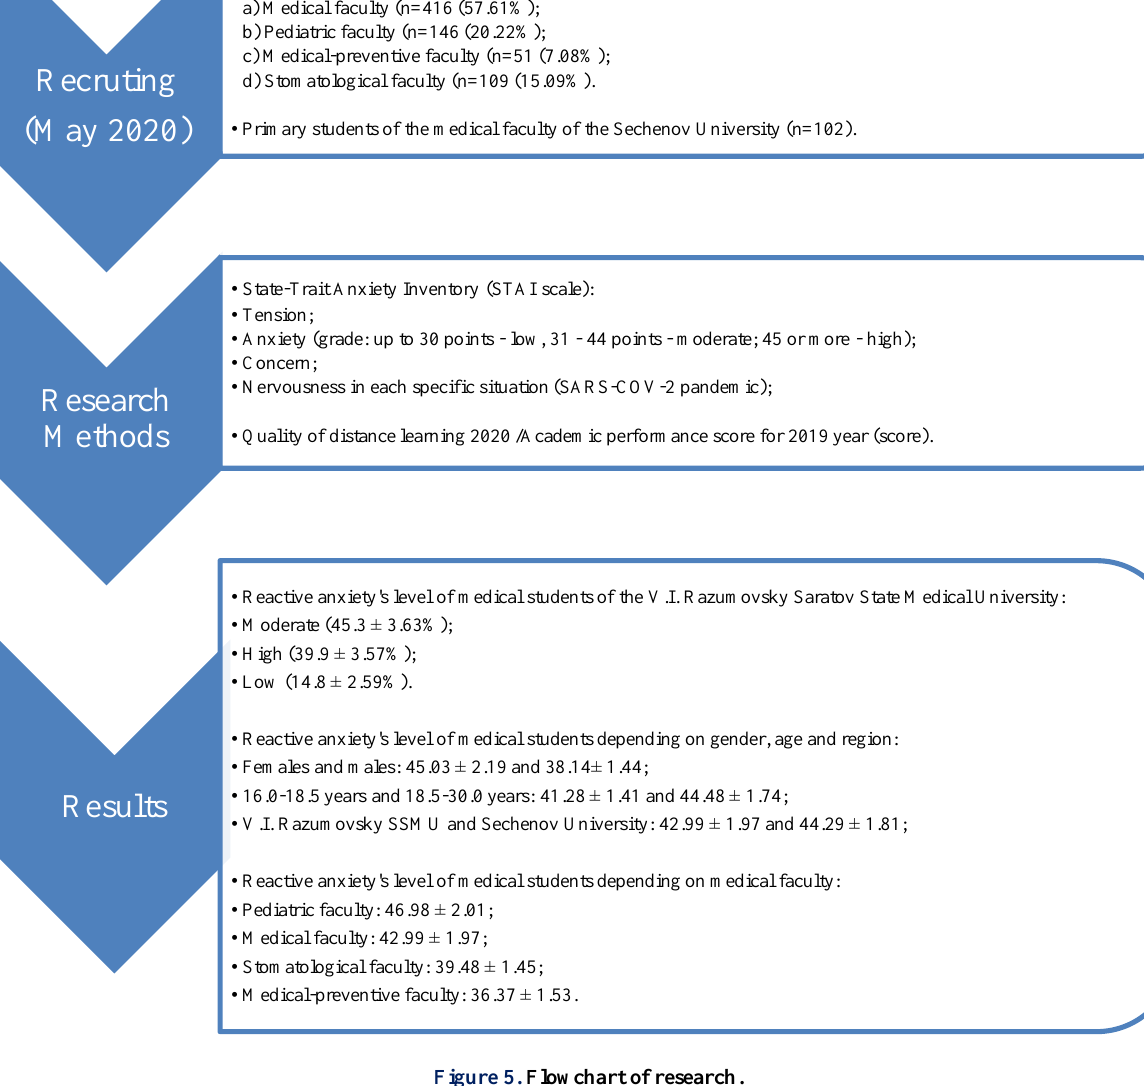
Figure 5. Flowchart of